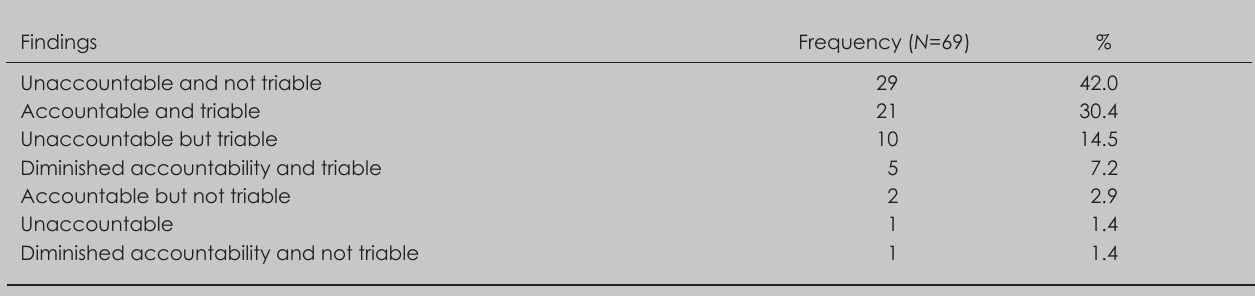
Table VI. Association between the diagnostic categories and findings in terms of sections 77 and/or 78 of the Criminal Procedure Act 51 of 1977